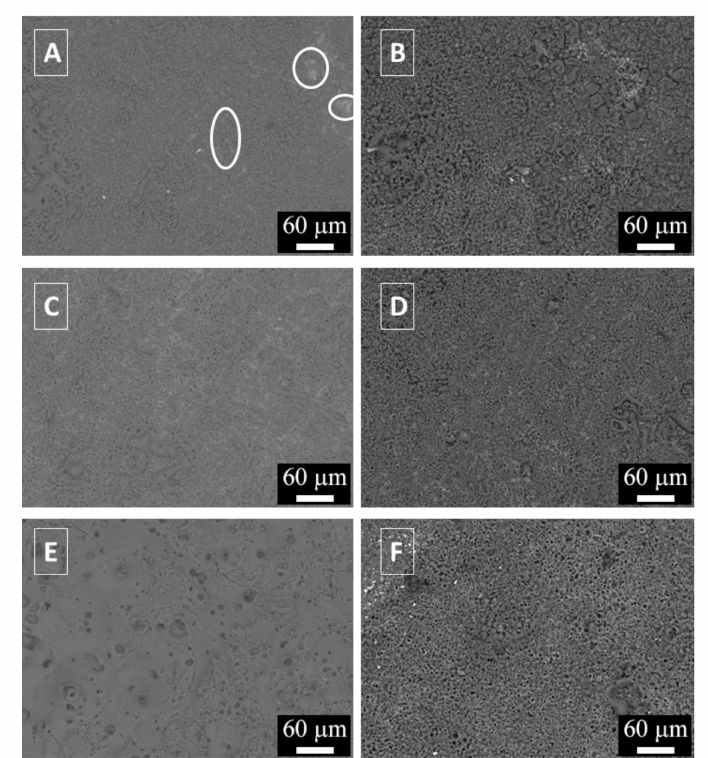
Figure 1. SEM images (backscattered electrons mode) of the surfaces of the samples: ( A ) Sample treated at 1.1 A / cm 2 for 2 min; ( B ) sample treated at 1.1 A / cm 2 for 3 min; ( C ) Sample treated at 1.7 A / cm 2 for 2 min; ( D ) Sample treated at 1.7 A / cm 2 for 3 min; ( E ) Sample treated at 2.3 A / cm 2 for 2 min; ( F ) Sample treated at 2.3 A / cm 2 for 3